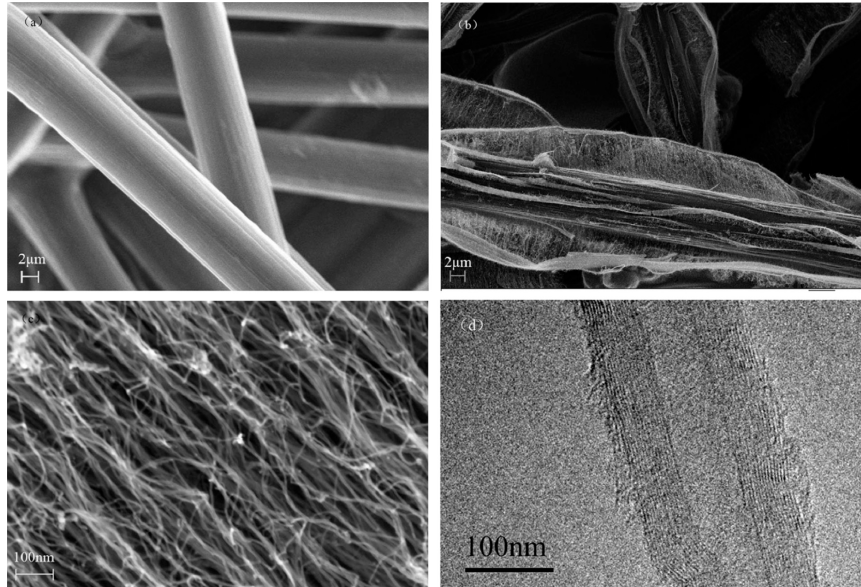
Figure 25. SEM micrographs of ( a ) before and ( b ) after growth of VACNT on CF paper coated with catalytic film, whereas ( c ) presents the VACNT at higher magnification; ( d ) TEM micrograph of the produced CNT. Reprinted with permission from Zhang, Journal of Physics and Chemistry of Solids; Ref. [123] copyright 2017,